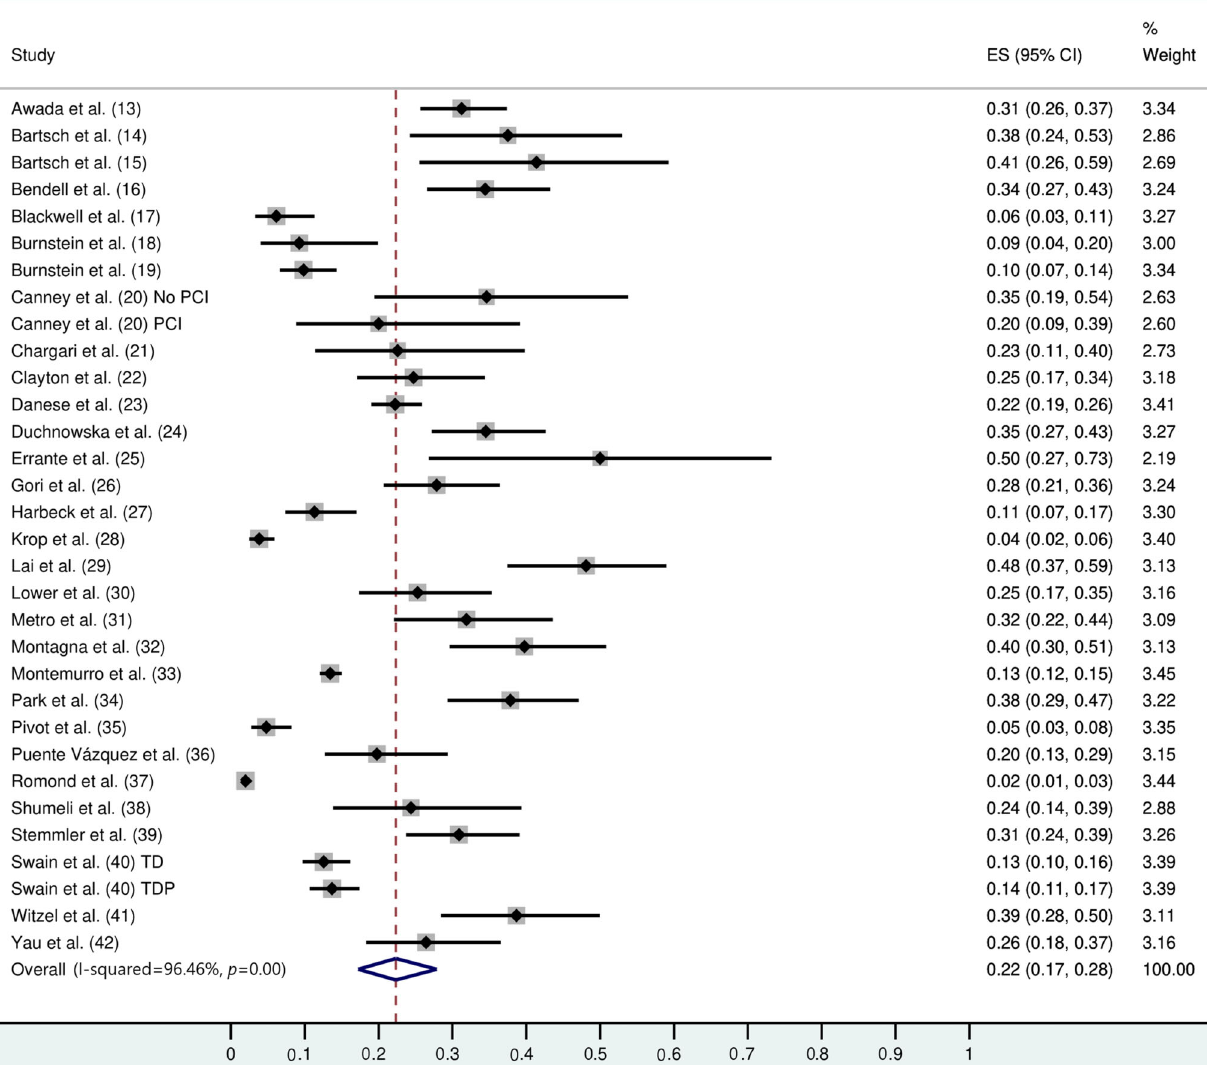
Figure 1 - Forest graph showing the results of the meta-analysis of the incidence rate of CNS metastases in patients with HER2-positive MBC treated with trastuzumab.